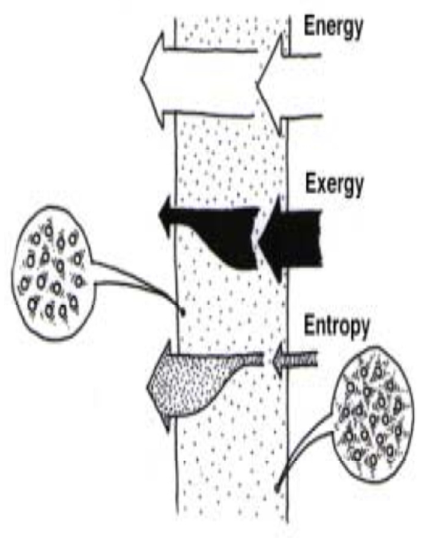
Figure 1. Illustration of energy, exergy, and entropy flow in and out of a building envelope system